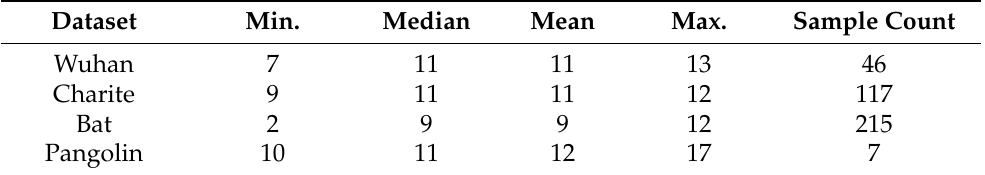
Table 1. This table presents the distribution of the number of predicted genes for each dataset. Bat-CoV exhibit the widest distribution of gene count, and pangolin-CoV has the highest number of gene count, with one genome having 17 predicted genes. These outliers have low sequence or assembly quality. In the case of the pangolin-CoV genome reporting 17 genes, it has low-quality (“NNNN”) nucleotide regions spanning the centre of genes, which causes PROKKA to identify the two ends of one gene. The median gene count only varying in bat-CoVs, likely attributed to the large phylogenetic variation exhibited across the bat-CoVs. Dataset Min. Median